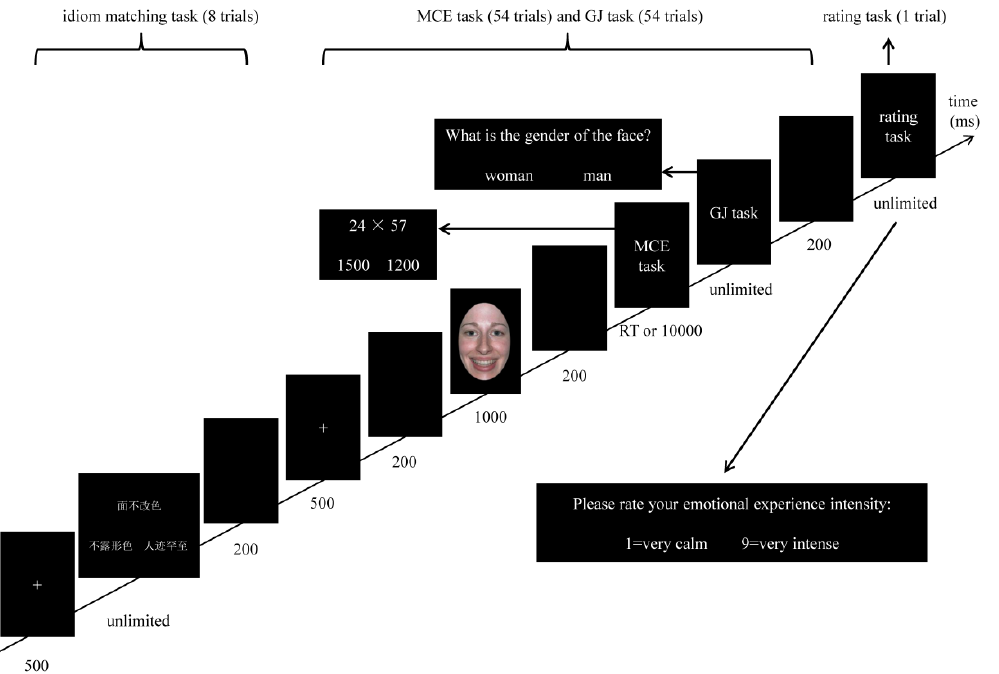
Figure 1. The illustration of single block. “ 面不改色 ” means keeping calm, “ 不露形色 ” means keeping calm, “ 人迹罕至 ” means desolate and remote places.